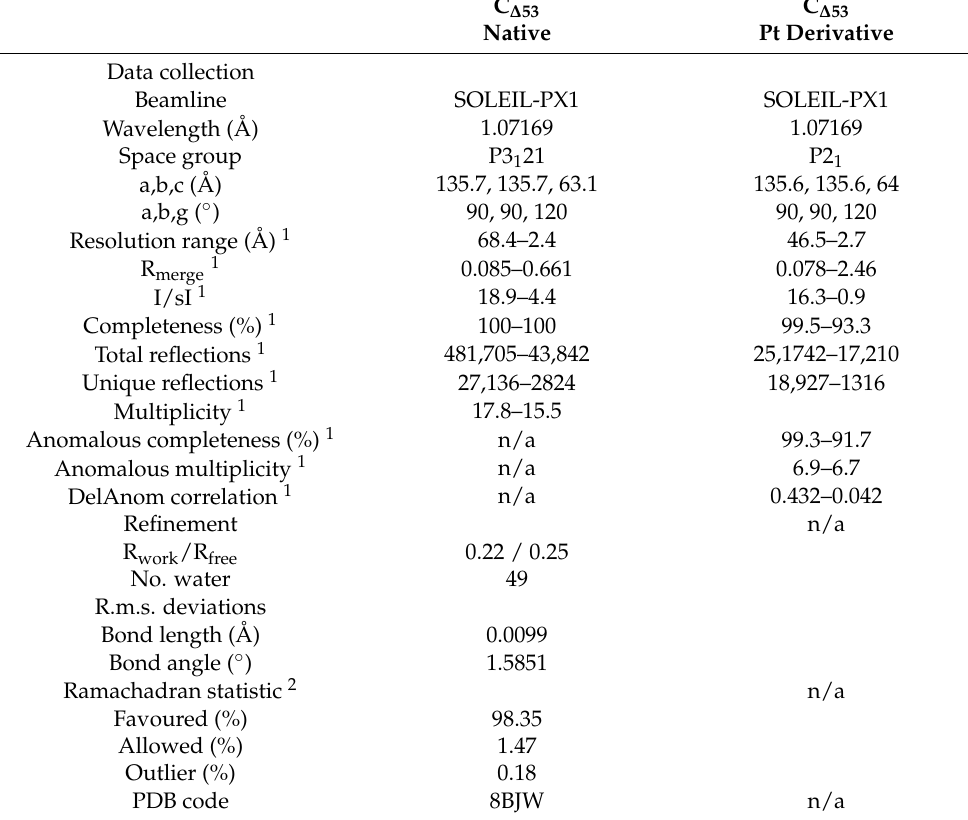
Table 1. Crystallographic Data Collection and Refinement